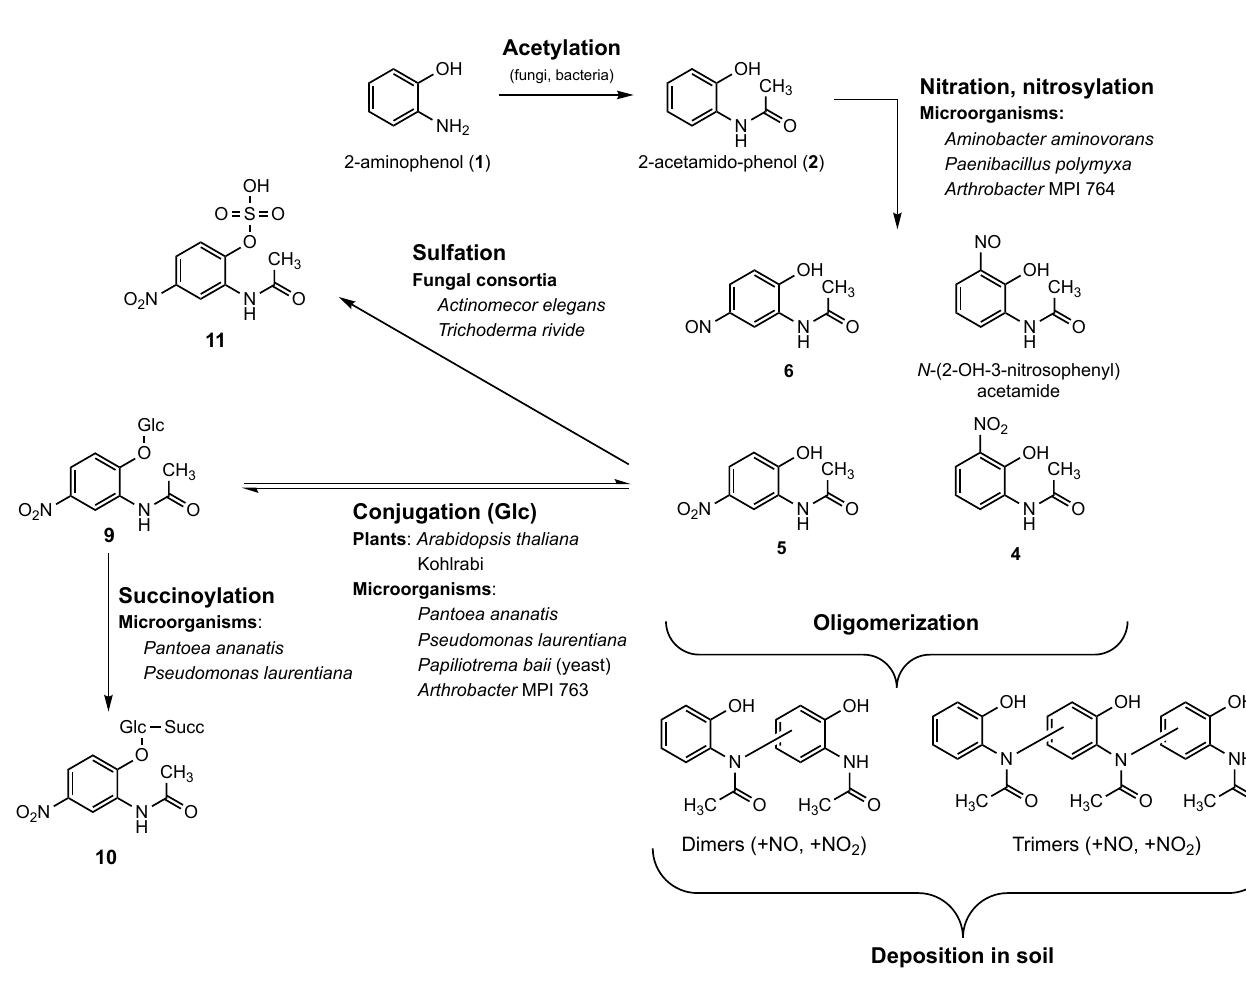
Figure 10. Alternative biotransformation of 2-aminophenol ( 1 ) by microorganisms and fungi in the presence of nitrate in